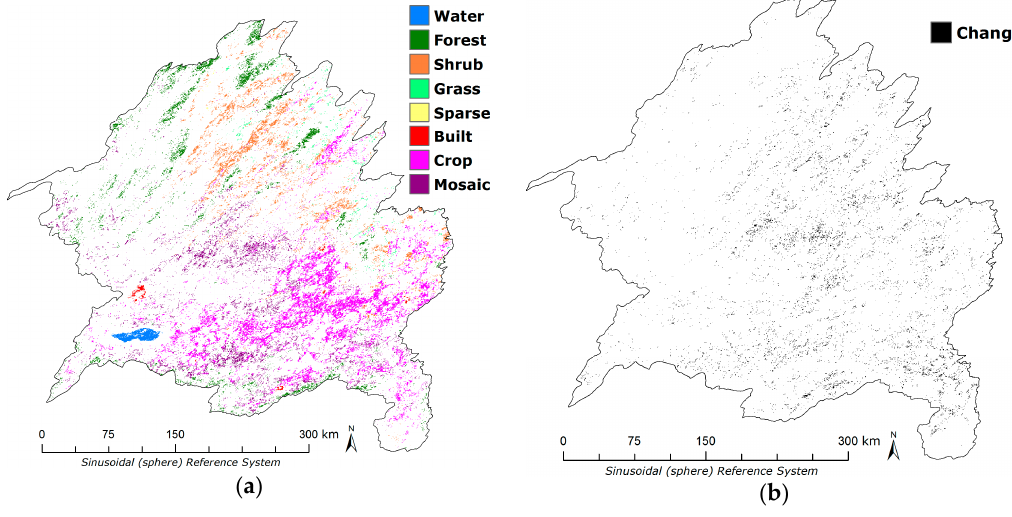
Figure 3. Selected regions of high confidence land cover persistence ( a ) and change from 2001 to 2007 ( b ) across the Lerma-Chapala-Santiago watershed.